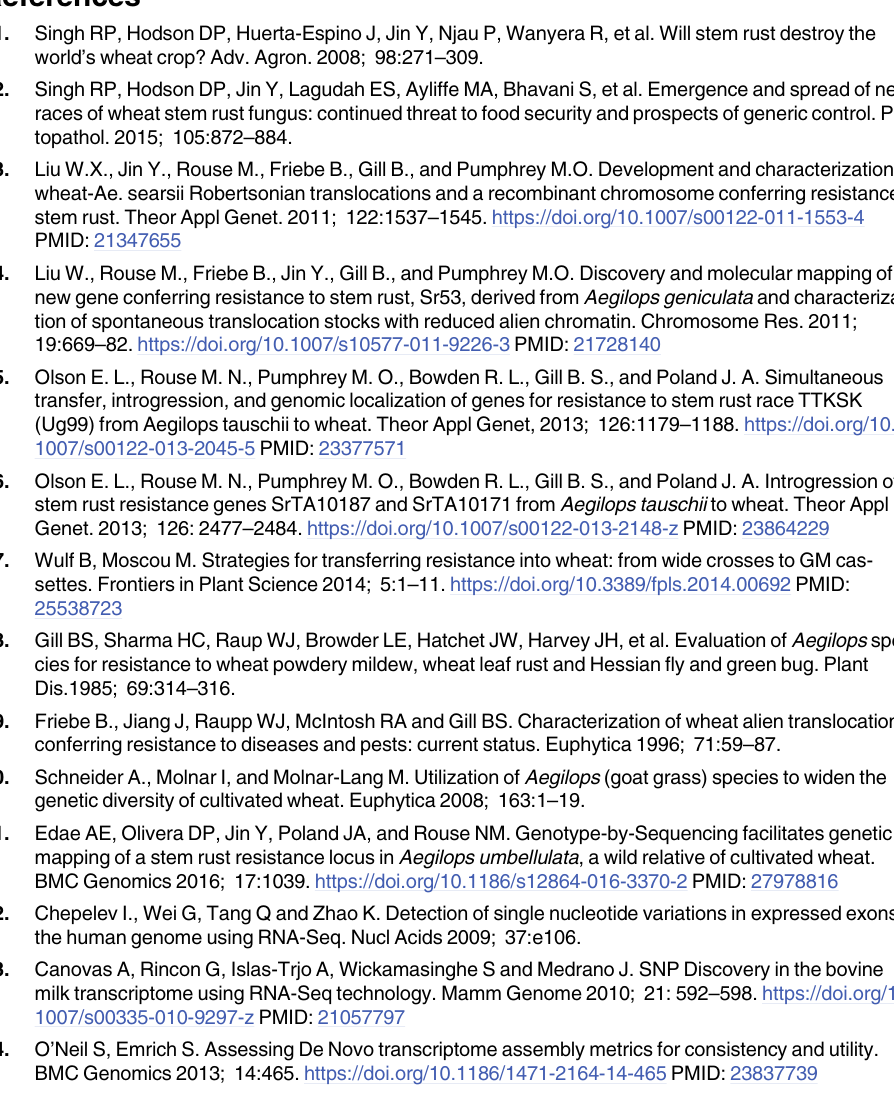
S4 Table. List of SNPs with bulk frequency ratio above 4 identified from chromosome 2D of Ae tauschii . S5 Table. List of transcripts that matched records in Uniprot.